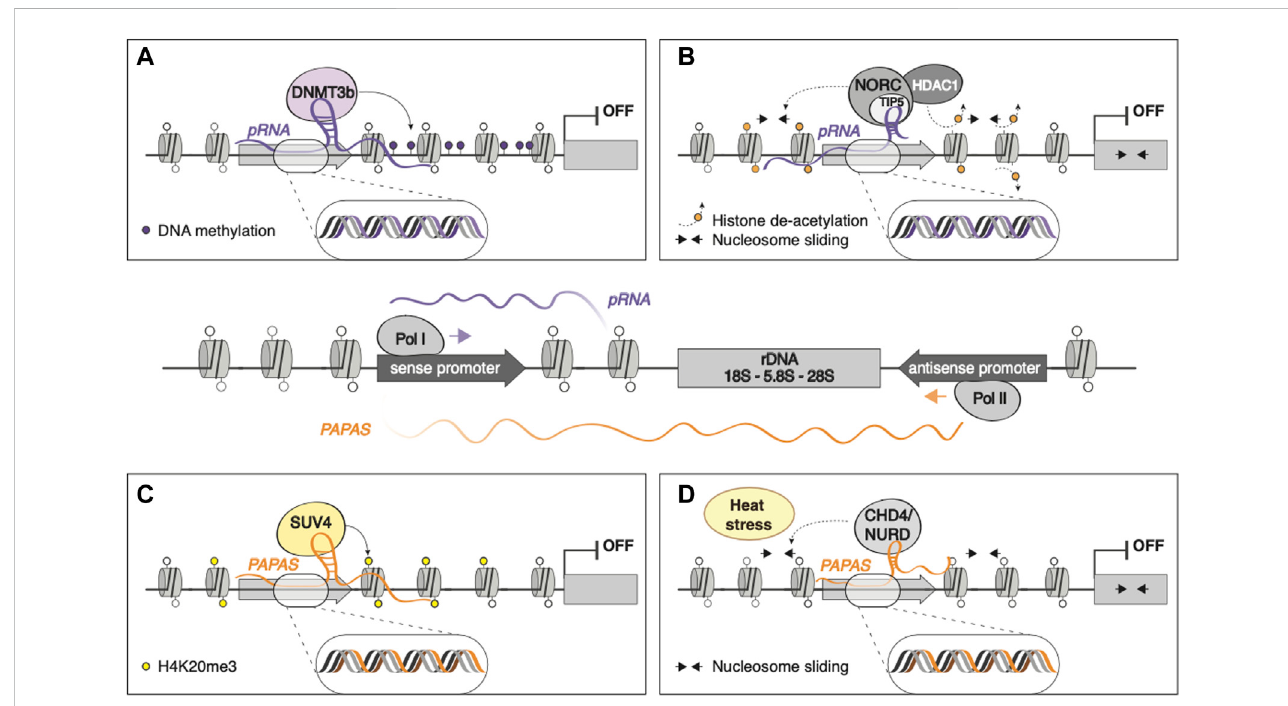
FIGURE 2 Theepigeneticcontrol ofrRNA:pRNAand PAPAS RNAPIbinding torDNA promotergives riseto thetranscription ofpRNA,whose sequencesmatch that of rDNA promoter. In contrast, the antisense transcription of rDNA, mediated by RNAPII, gives rise to PAPAS , spanning from rDNA gene body to intergenic, promoter, and enhancer regions (Figure, central panel). pRNA can mediate the silencing of rDNA loci by (A) directly recruiting DNMT3b, leading to de novo methylation and heterochromatinization; (B) binding NoRC and HDAC, promoting nucleosome sliding and deacetylation, respectively. (C) PAPAS leads to rDNA silencing by recruiting SUV4 on rDNA promoter. (D) PAPAS can associate with the chromatin remodeling complex CHD4/NuRD and guide it on the rDNA locus to promote nucleosome shifting and transcriptional repression of rDNA in a heat stress-dependent